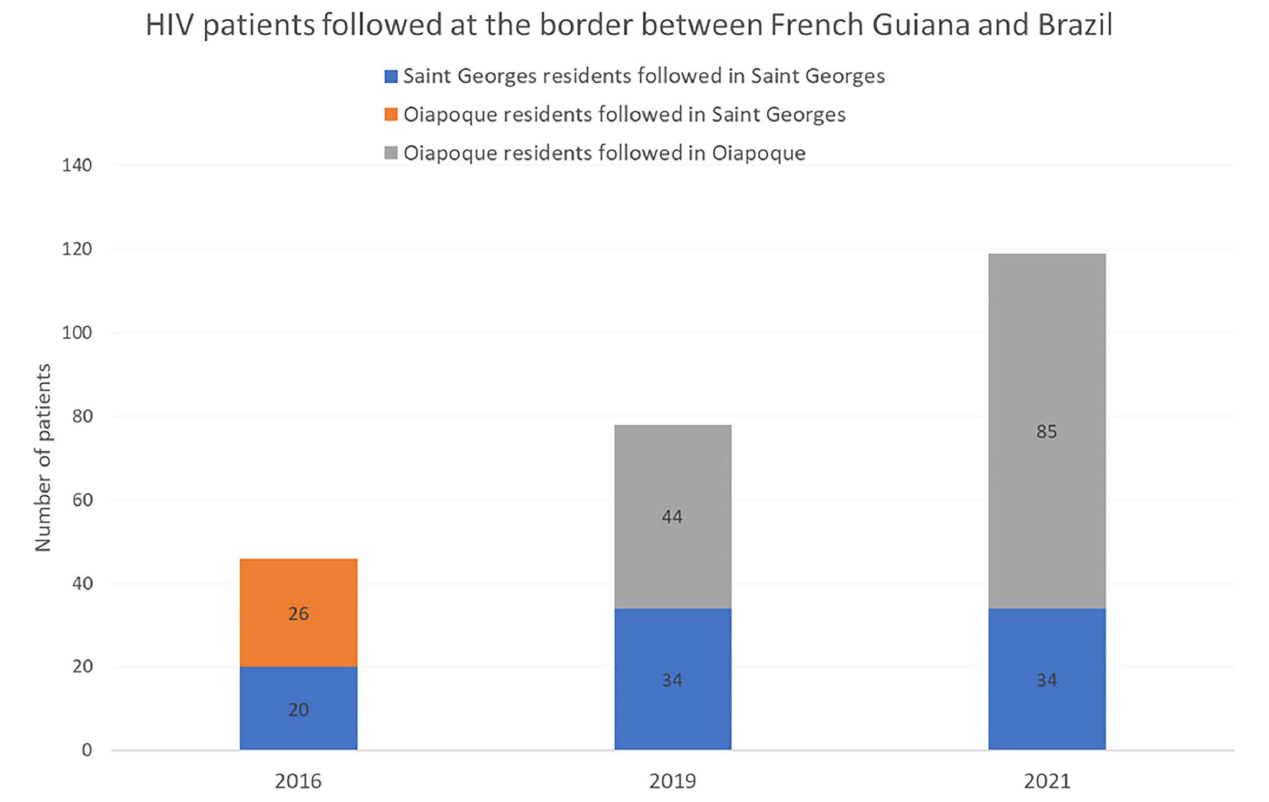
FIGURE2 Evolution of the number of persons living with HIV followed in Saint Georges de l’Oyapock and Oiapoque before and after the availability of HIV care in Oiapoque.